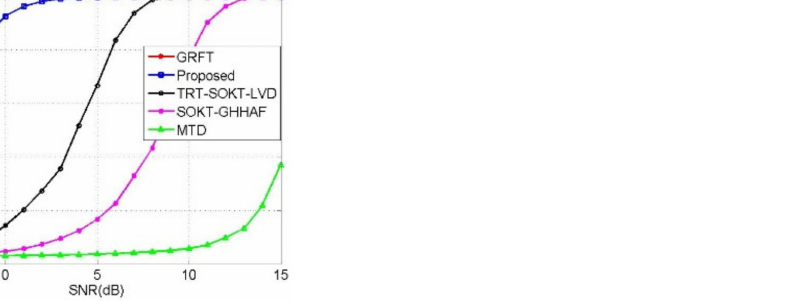
Figure 7. Curves of detection probability varying with range compression signal-to-noise ratios